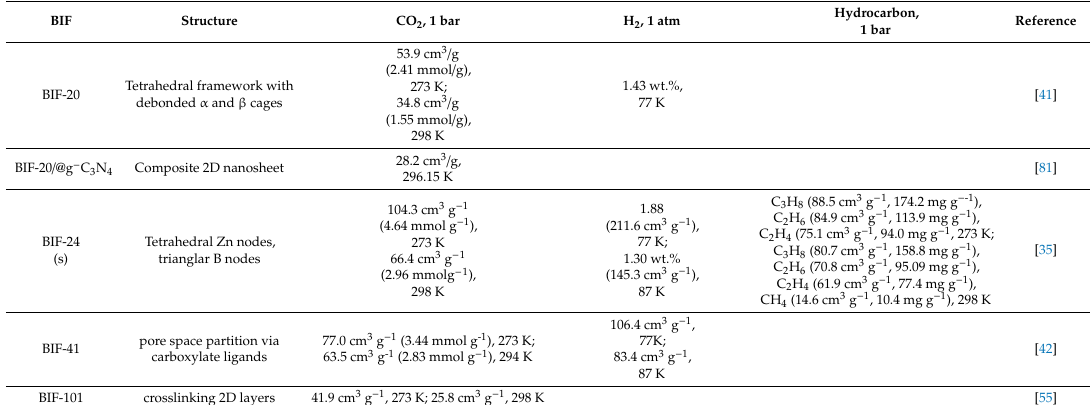
Table 2. Uptake values for the selected BIF